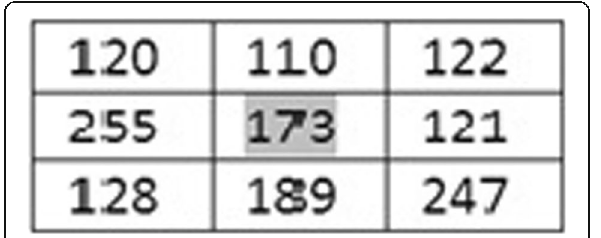
Fig. 9 Example of corrupted image segment for case